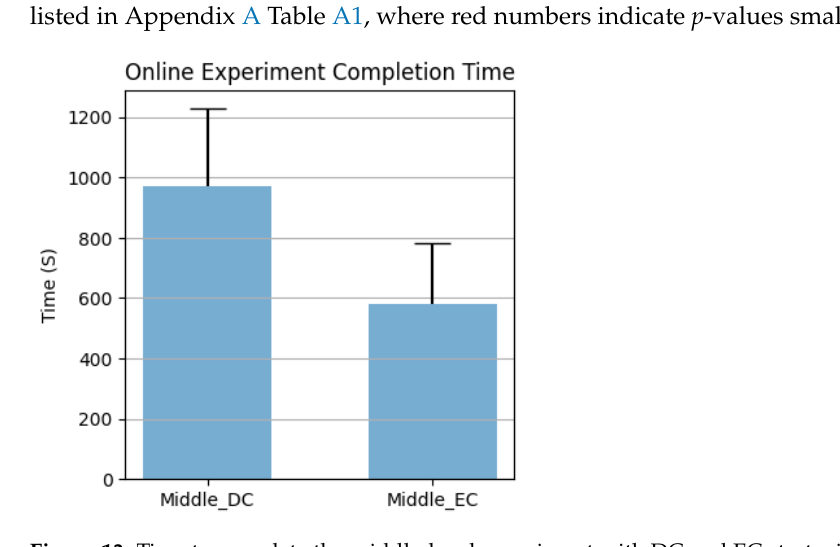
Figure 13. Time to complete the middle-level experiment with DC and EC